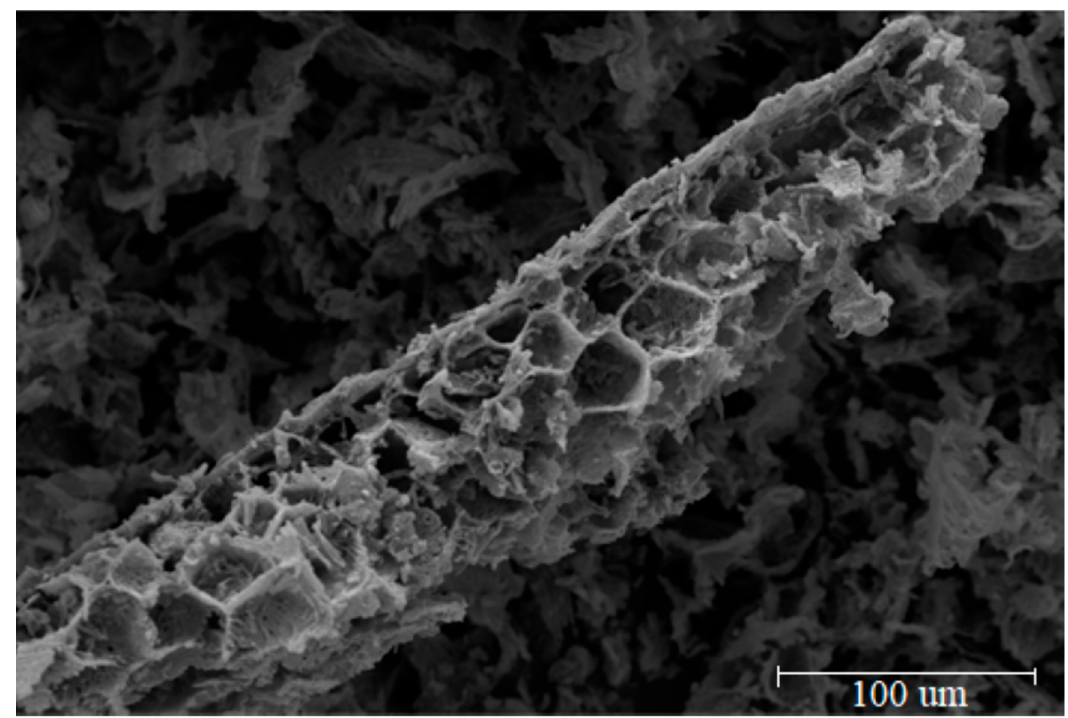
Figure 2. Microscopy image obtained from SEM for the adsorbent prepared from Moringa oleifera Lam. seeds.